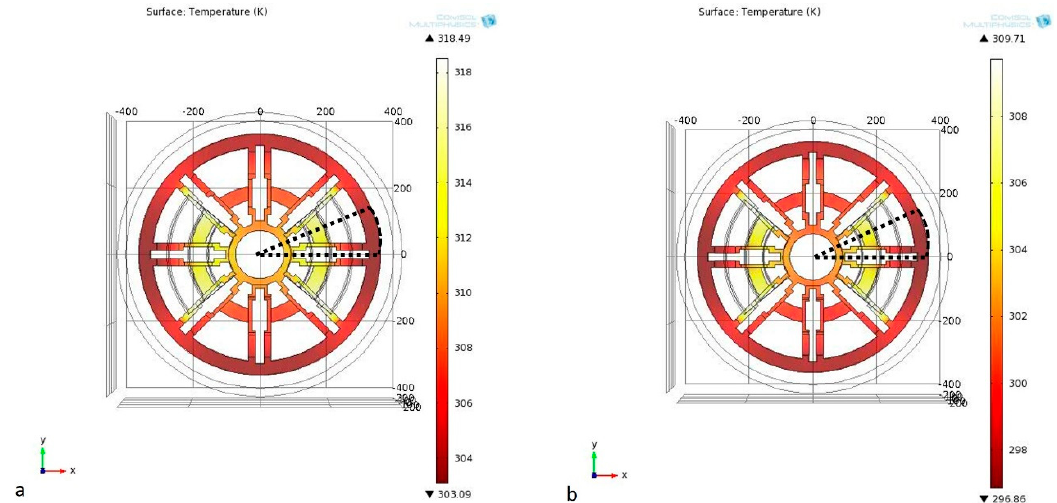
Figure 6. Temperature distribution on the MCW surface for a rotating frequency of 0.72 Hz, an ambient temperature of 20 °C and different heat transfer coefficients: 20 ( a ) and 30 ( b ) W m − 2 K − 1 . In the figures, the area of interest for the simulation is evidenced (black dotted lines).